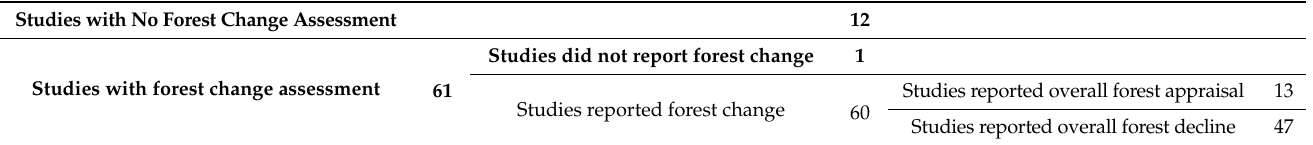
Table 3. Forest change assessment statistics in different areas of Pakistan